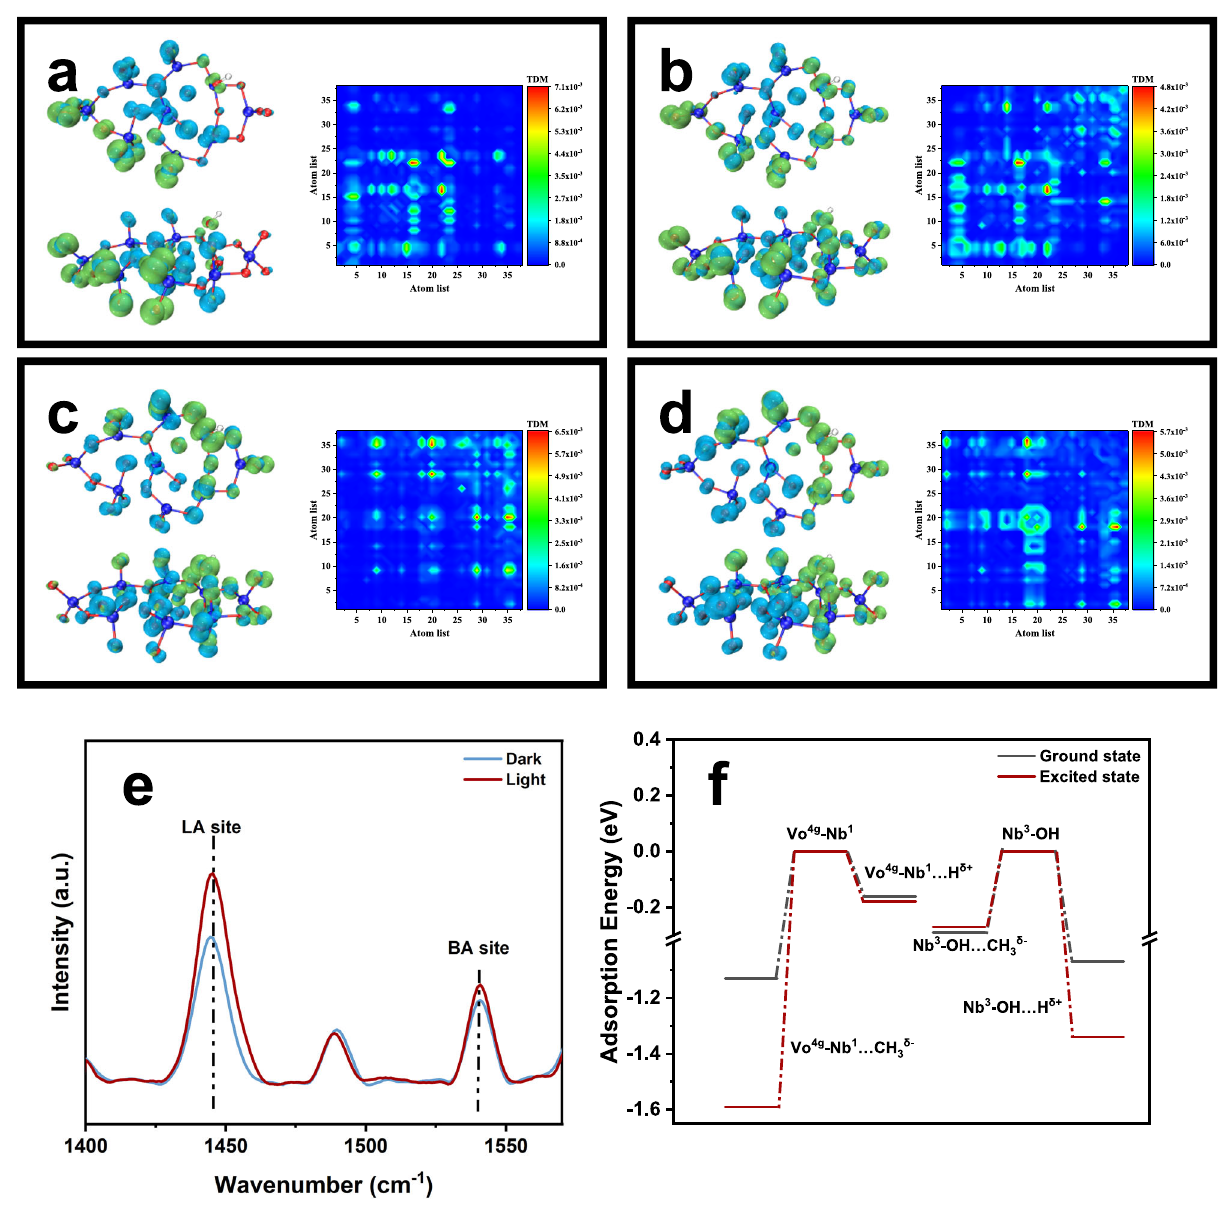
Fig. 5 | DFT calculations for photocatalytic methane activation. Analysis of electron-hole pairs of Vo-Nb 1 -O-Nb 3 -OH model in the ( a )S 0 → S 75 , ( b ) S 0 → S 83 , ( c ) S 0 → S 139 , and ( d ) S 0 → S 149 excitations, respectively. The transition dipole moment